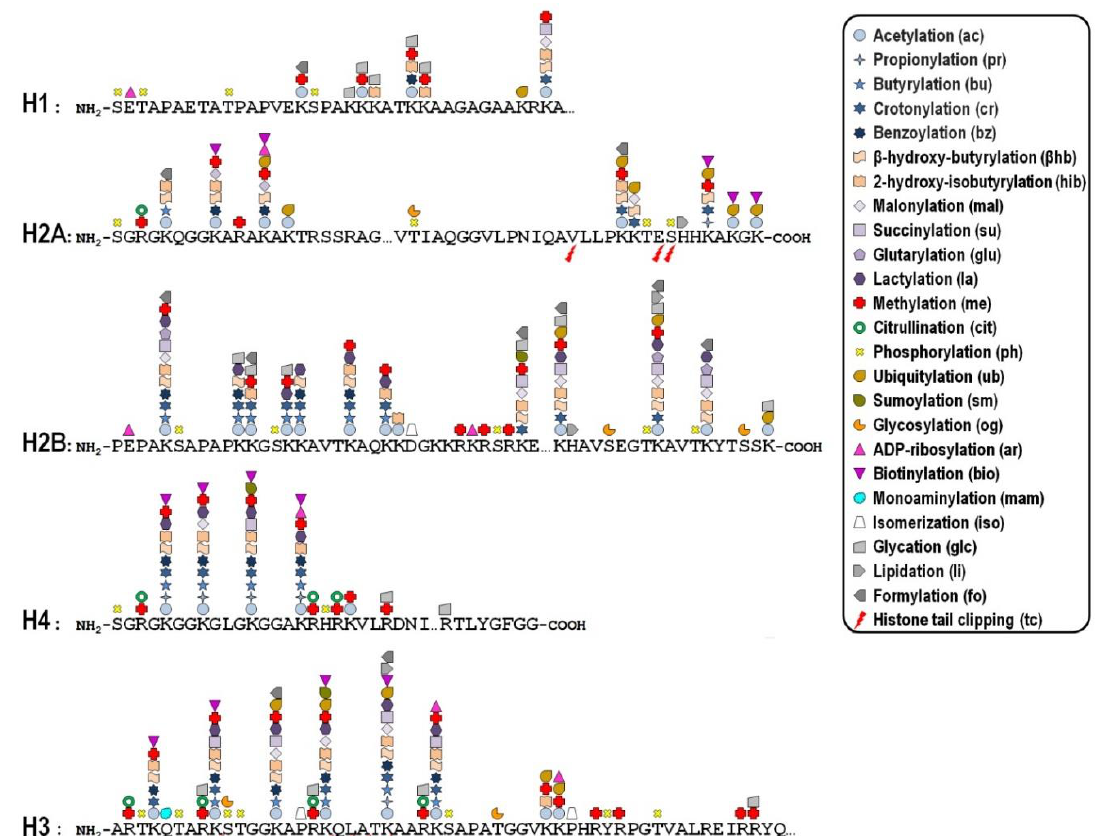
Figure 1. Diagrammatic representation showing the distribution of post-translational modifications within the N- and C-terminal portions of the five canonical histones. The first amino acid methionine was omitted from the sequences. Key for each histone PTM is included in diagram. Reference sequences of histone proteins were retrieved from the NCBI protein database (https://www.ncbi.nlm.nih.gov/protein?cmd=retrieve; accessed on 2 October 2021) using the following accession numbers: NP_005313.1 (H1), NP_003504.2 (H2A), NP_066406.1 (H2B), NP_003520.1 (H3), and NP_003529.1